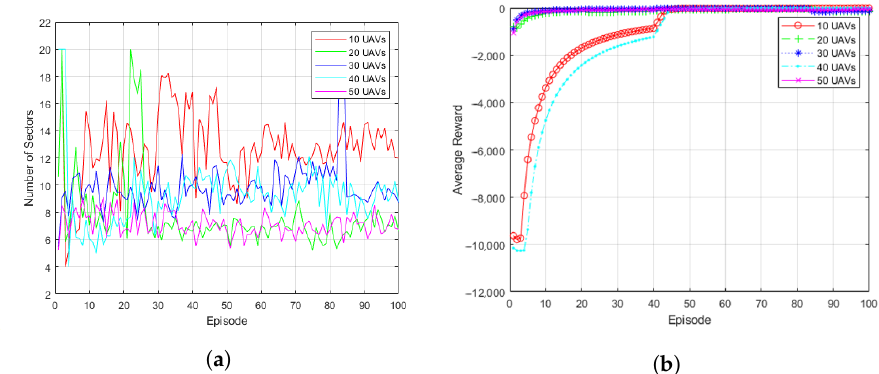
Figure 7. Simulation results of the arbitrary UAV formations (10, 20, 30, 40, 50 UAVs): ( a ) Subspace Change. ( b ) Episodic